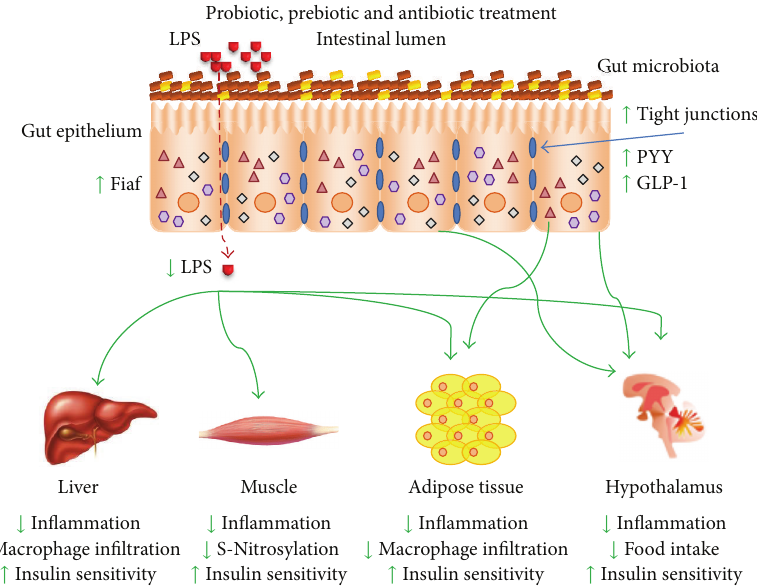
Figure 2: The advent of products (antibiotics, probiotics, and prebiotics) capable of modulating the gut microbiota profile, their products and metabolites (i.e., LPS, short-chain fatty acids), promotes a shift on the bacterial community prevalence, which favored the increase in tight junctions expression and function, reducing intestinal permeability and bacterial products circulation levels. Thus, the LPS circulating levels and inflammatory status in insulin-sensitive tissues are reduced, as well as muscle S-nitrosylation and liver and adipose tissue macrophage infiltration, promoting increased insulin sensitivity and the whole body metabolism. GLP-1 and PYY circulating levels are increased after treatment with gut microbiota modulators which together with the improvement in insulin sensitivity in the hypothalamus promoted reduction in food intake by satiety mechanisms and in conjunction with the increased Fiaf expression, contributed to reduce body